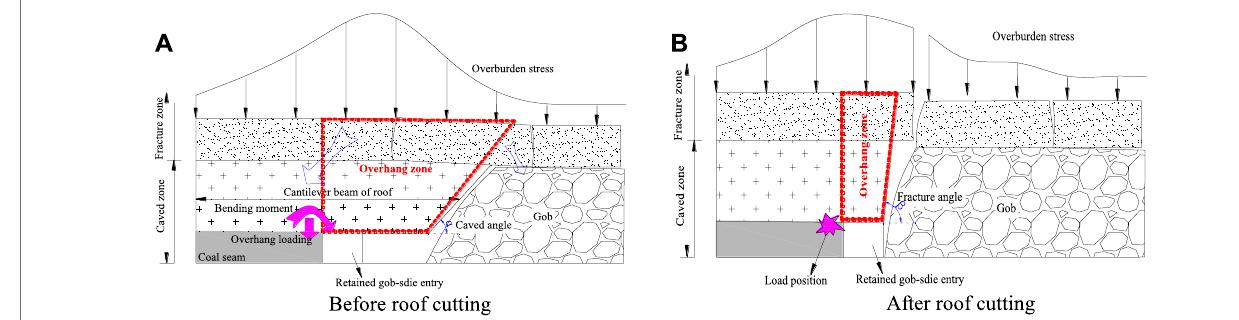
FIGURE 8 | Mechanism of roof cutting. (A) Before roof cutting. (B) After roof cutting.